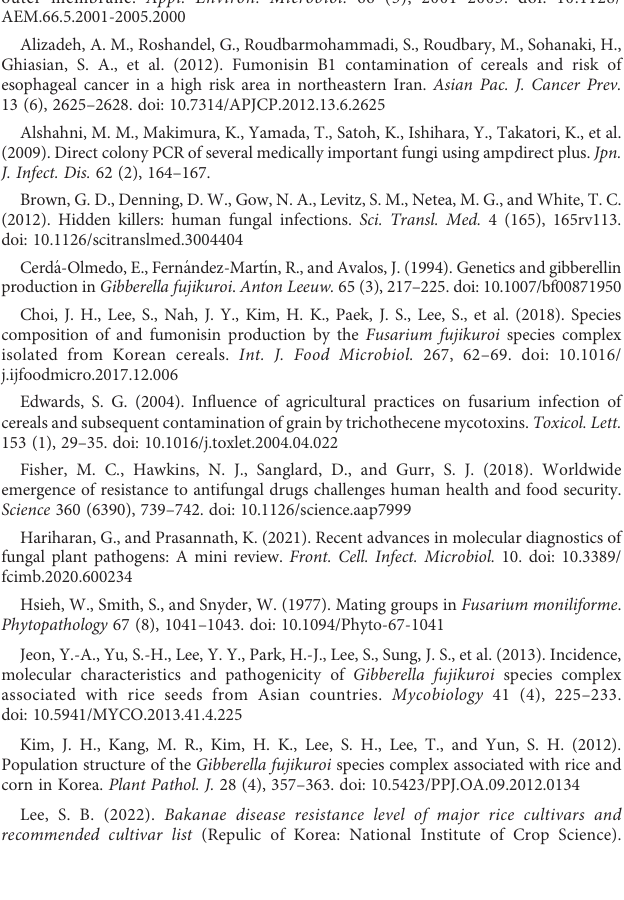
SUPPLEMENTARY FIGURE 1 Gel electrophoresis images of ampli fi ed products of FFSC strains using the direct PCR approach. To amplify target regions (ITS and TEF-1 a ), we used primerpairsITS4/ITS5andEF1T/EF2TfordirectPCR, andtheampli fi edproducts were loaded on a 1.5% (w/v) agarose gel. The target regions and size of amplicons are shown on the left. SUPPLEMENTARY FIGURE 2 Incidence of the F. fujikuroi strains from Korean rice cultivars. Seventeen F. fujikuroi strains were recovered from rice seeds. Among the 17 strains, 7 were isolated from Chamdongjin. The other strains were isolated from other cultivars (Haepoom, Hyunpoom, Boramchal, Shindongjin, Saebonghwang, Mokyang, Mipoom, and Alchanmi). SUPPLEMENTARY FIGURE 3 Direct PCR ampli fi cation using primer pairs B14J06375F2/B14J05375R2 and B20J12141F2/B20J12141R2 for B14-type and B20-type, respectively. The primer pairs for B14-type and B20-type were derived from PKS51 and NRPS31 ,